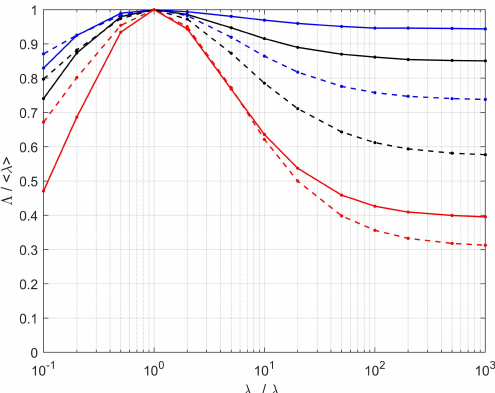
Figure 10. Eigenvalues of Λ obtained by DNS in the tomographies of [S1] (solid lines) and [S2] (broken lines), normalized by (cid:104) λ (cid:105) , as functions of λ s / λ g